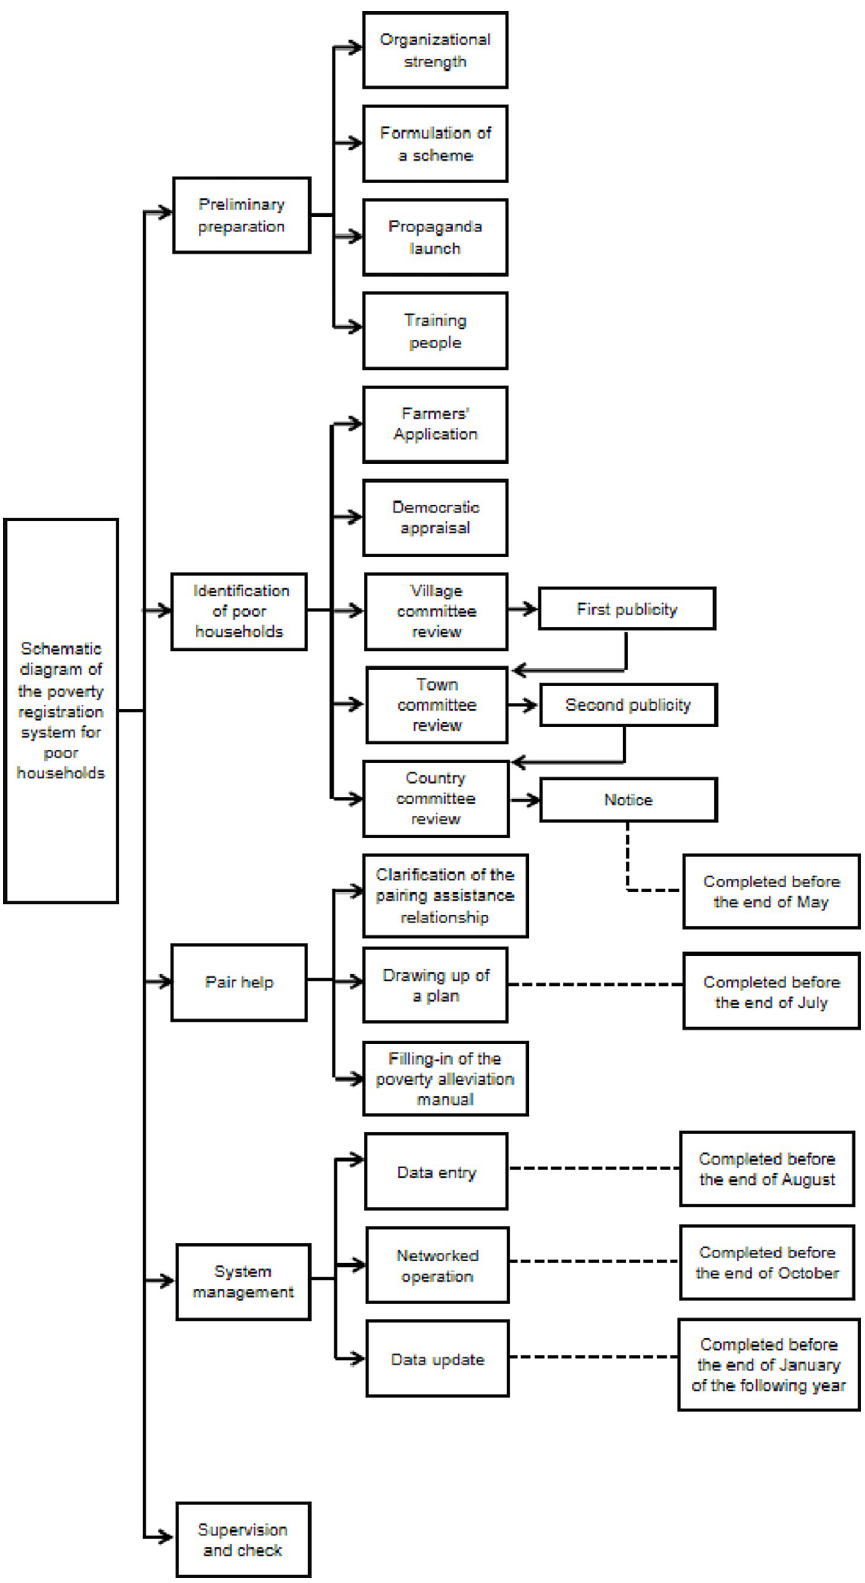
Fig 1. Functional diagram of the poverty registration of poor